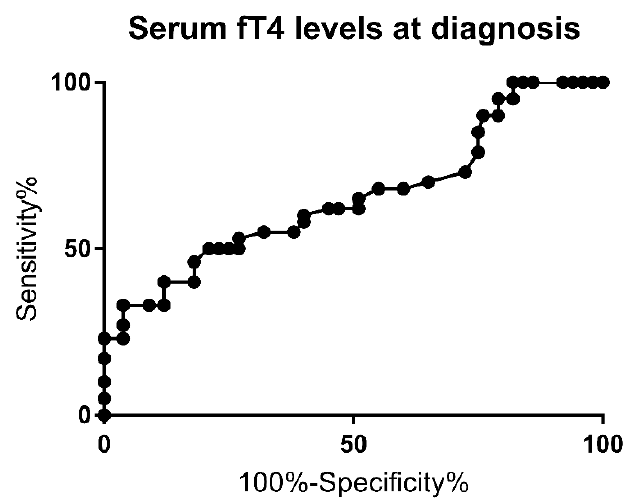
Figure 2. Receiver Operating Curve (ROC) for fT4 level at the time of